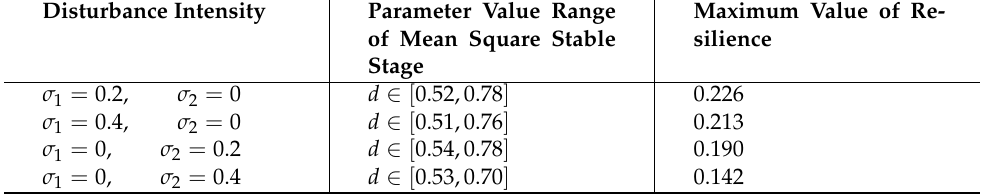
Figure 4. Resilience and reactivity (in the mean-square sense) of the positive equilibrium of (11). The variable parameter is c , fixed parameters a = 2.0, b = 0.7808. In ( a ), σ 1 = 0.2, σ 2 = 0. In ( b ), σ 1 = 0.4, σ 2 = 0. In ( c ), σ 1 = 0, σ 2 = 0.2. In ( d ), σ 1 = 0, σ 2 = 0.4. Table 1. Information summary of Figure